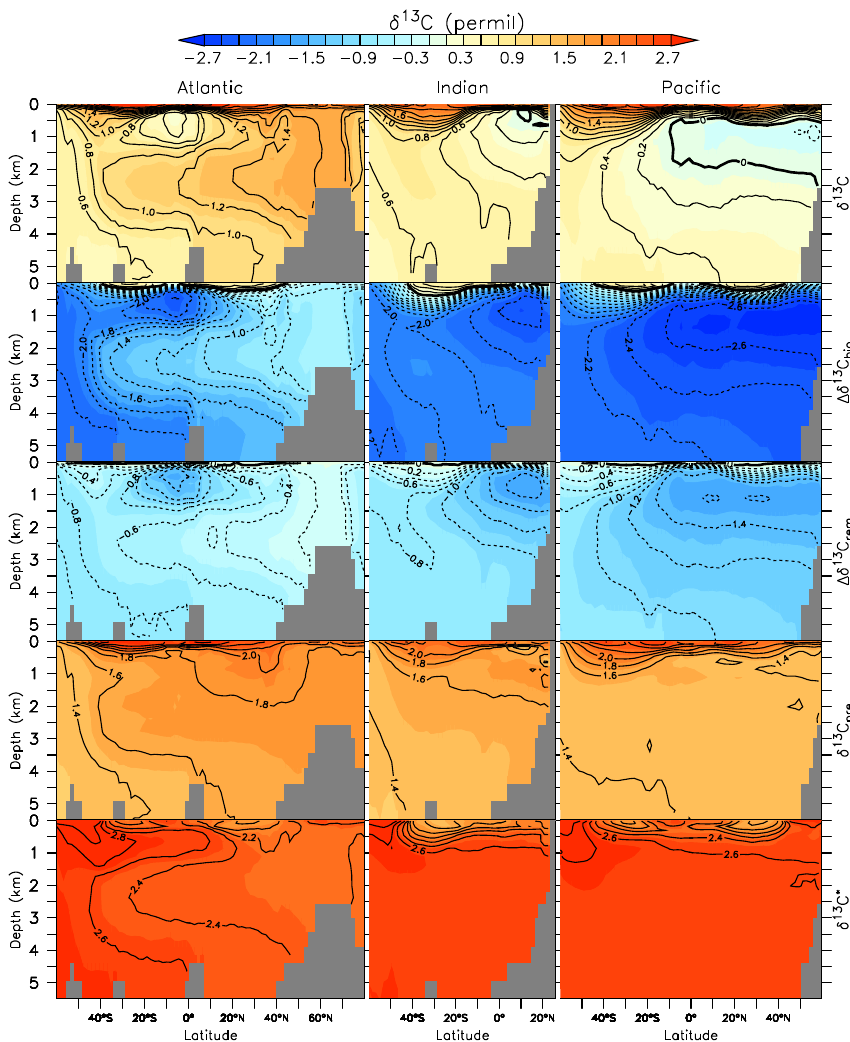
Fig. 6. Zonally averaged preindustrial δ 13 C DIC (top), 1δ 13 C bio (second from top), 1δ 13 C rem (center), δ 13 C pre (second from bottom), and δ 13 C ∗ (bottom) in model std in the Atlantic (left), Indian (center) and Pacific (right)